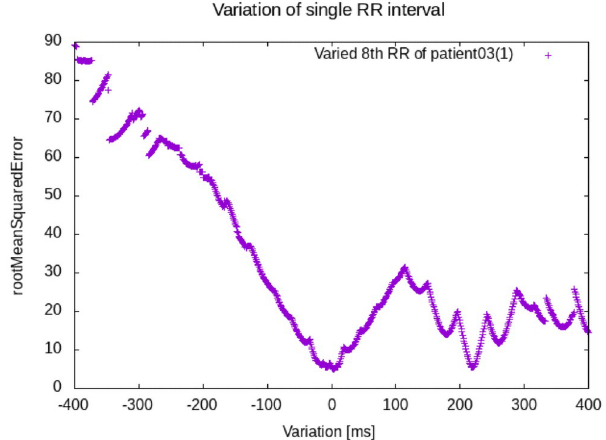
Fig 7. Fluctuation of the objective function of our mathematical model with respect to shifts in one input signal of a data sample.